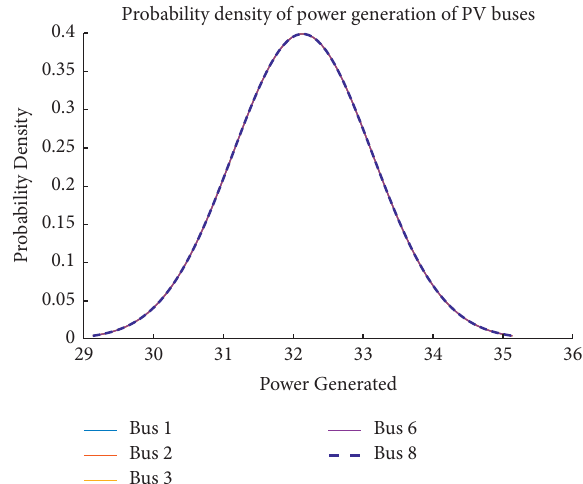
Figure 20: Power density distribution at buses 1, 2, 3, 6, and